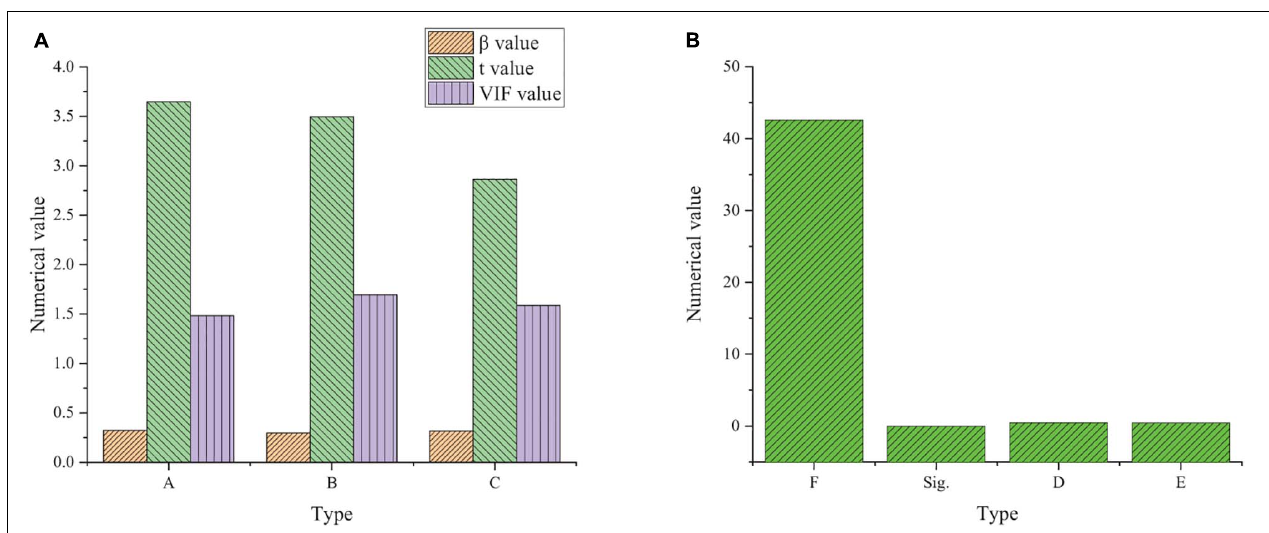
FIGURE 5 | Multiple regression analysis of entrepreneurial passion, risk-taking and work engagement on entrepreneurial performance [ (A) data analysis data; (B) calculation and statistics; A, Entrepreneurial passion; B, Risk taking Work; C, engagement; D, R 2 ; E, (cid:77) R 2 ].